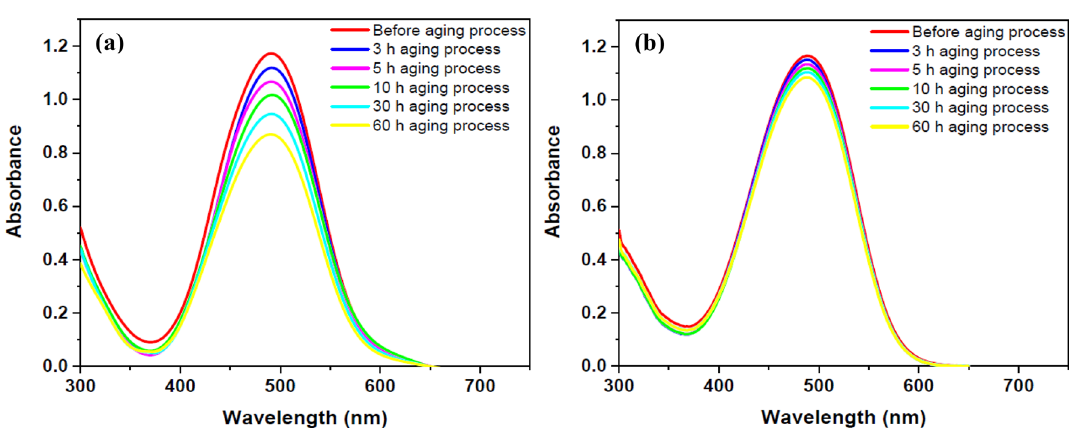
Figure 7. UV–Vis spectra of DR1 dye-loaded PMMA polymer films after different times of aging process: ( a ) untreated dye-loaded film ( b ) plasma modified dye-loaded film for treatment time of 300